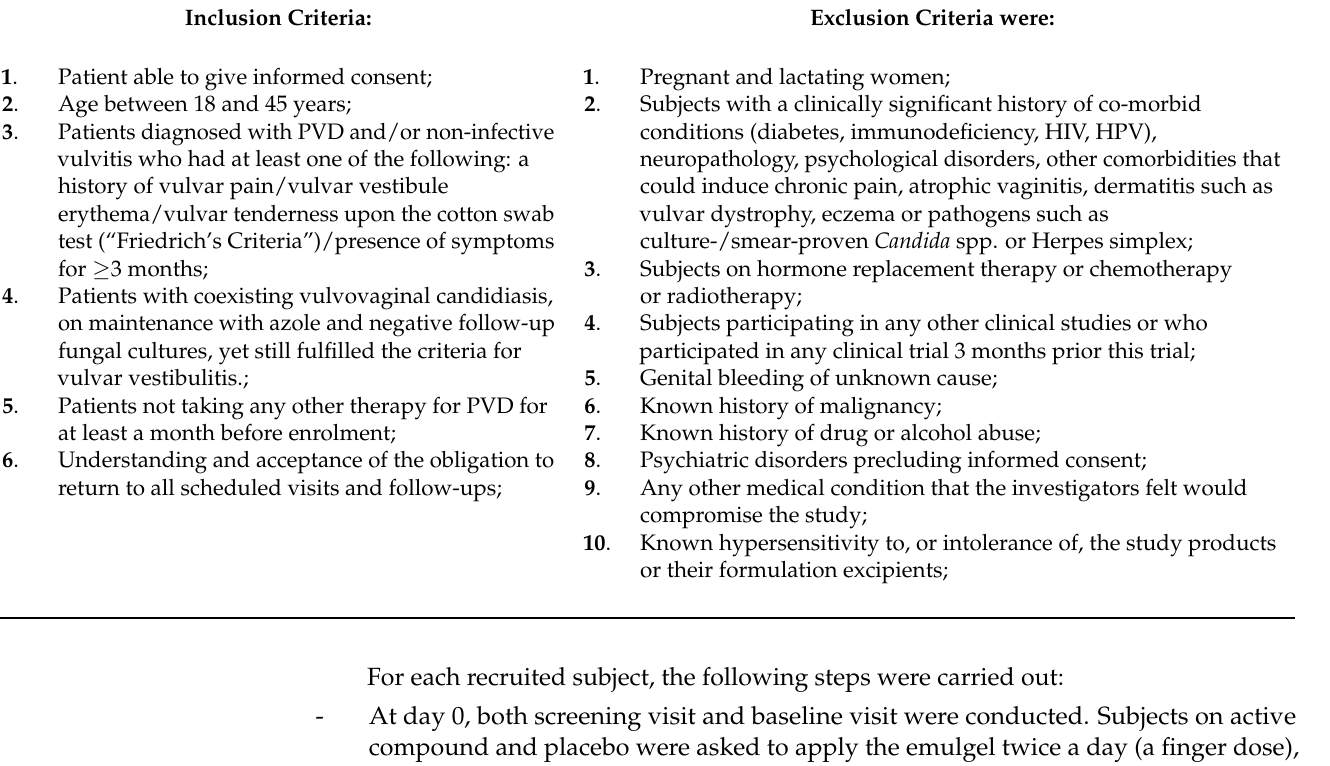
Table 1. Inclusion and exclusion